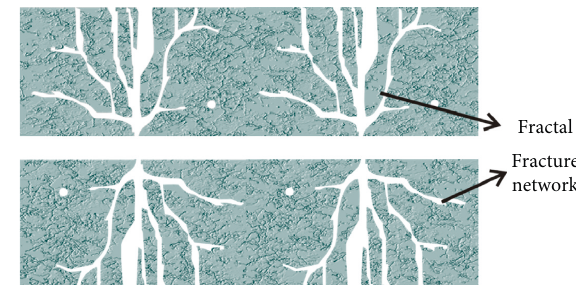
Figure 1: Schematic diagram of fractal fracture characteristics (revised from [24]).